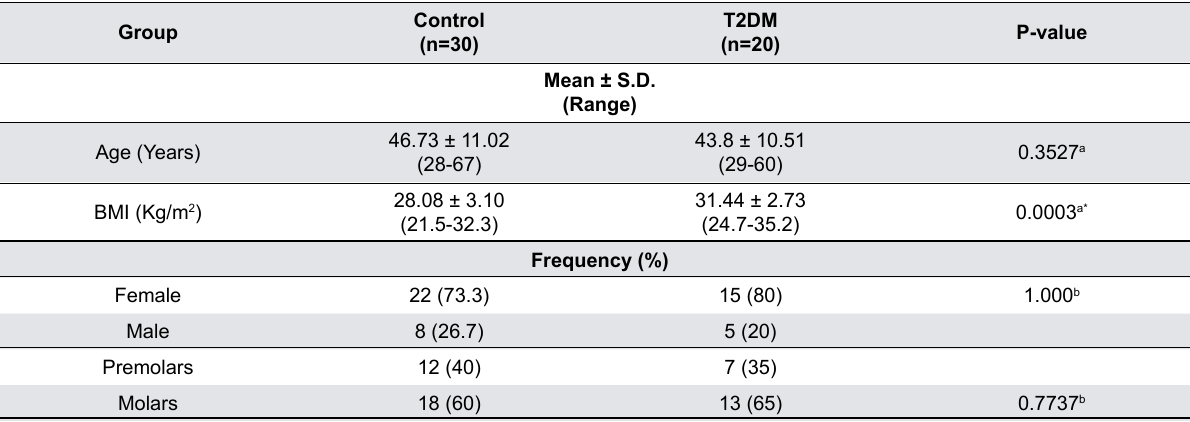
Table 2- Clinical characteristics of the included subjects and teeth in both